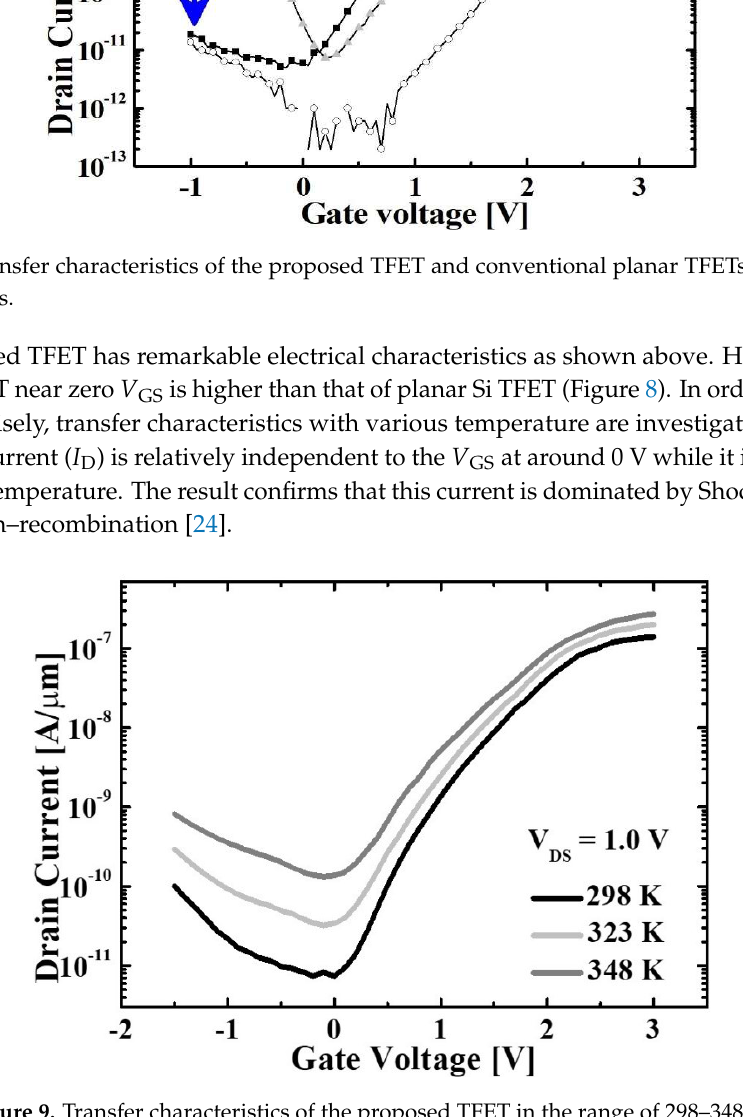
Figure 9. Transfer characteristics of the proposed TFET in the range of 298–348 K.